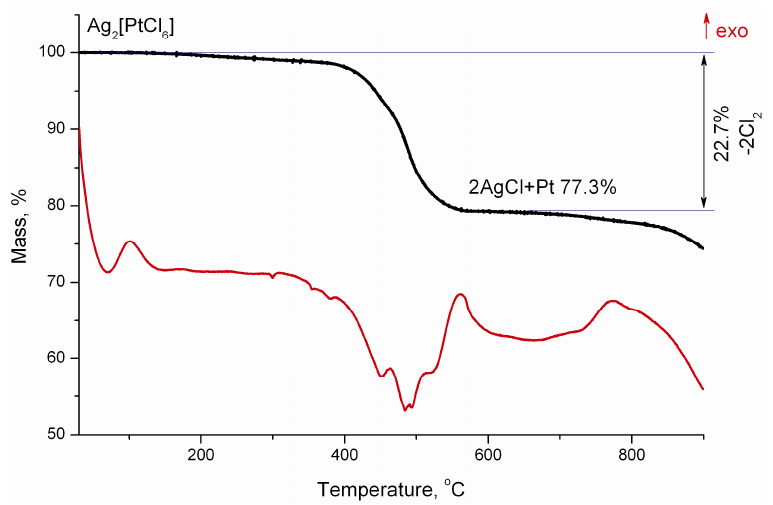
Figure 5. Mass loss curves and differential thermal analysis of Ag 2 [PtCl 6 ] in a helium atmosphere. Above 760 °C, further mass loss occurs which corresponds to the sublimation of silver chloride, while only platinum metal remains in the solid residue.